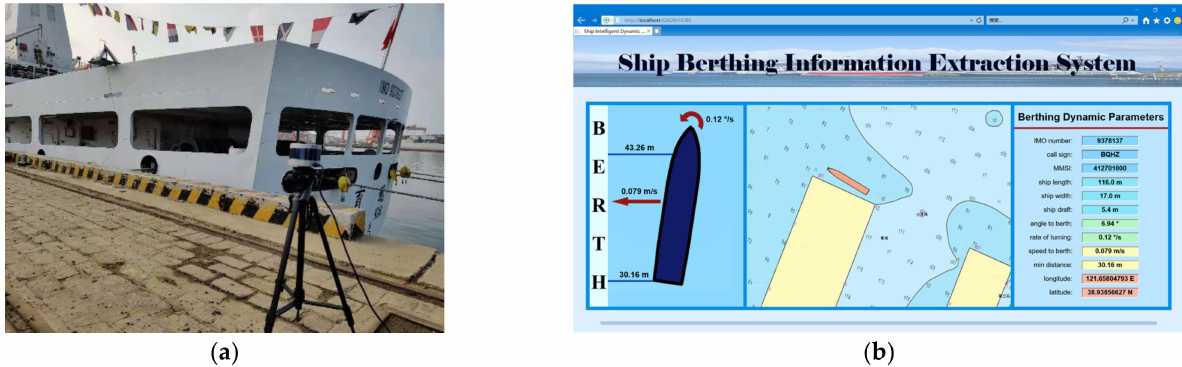
Figure 20. Experiments and applications: ( a ) experiments with Ship Yukun at Dalian port; ( b ) the developed web page of the monitoring data